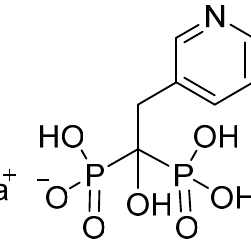
Figure 1. Structure of sodium salt of